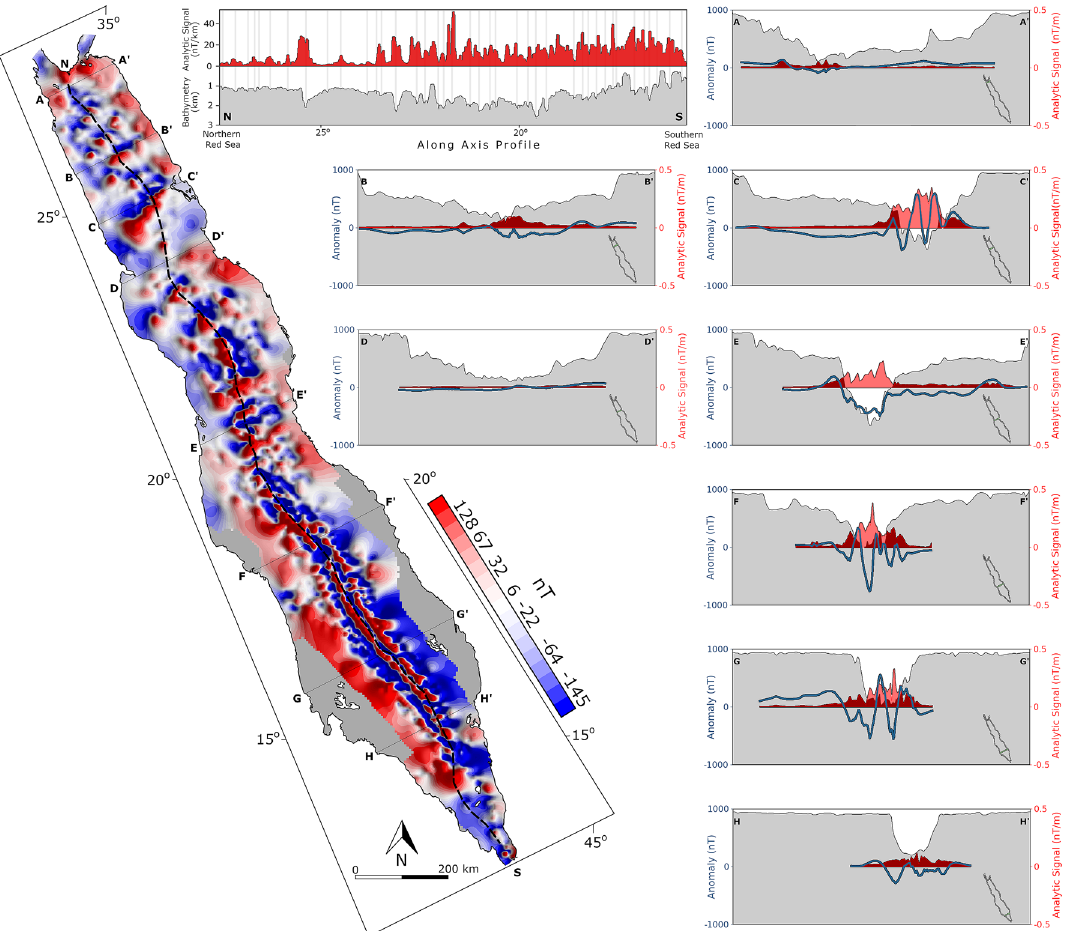
Figure 2. New magnetic anomaly map for the Red Sea and representing cross-sections. The map was produced from reprocessed track line data, conformed to satellite magnetic model (LCS-1). The magnetic data was gridded using minimum curvature algorithm with 5 km 2 grid cell. Dashed black line marks the Red Sea axis. Cross-sections show: bathymetry (grey; 0 to 3 km), magnetic anomaly (blue), analytic signal